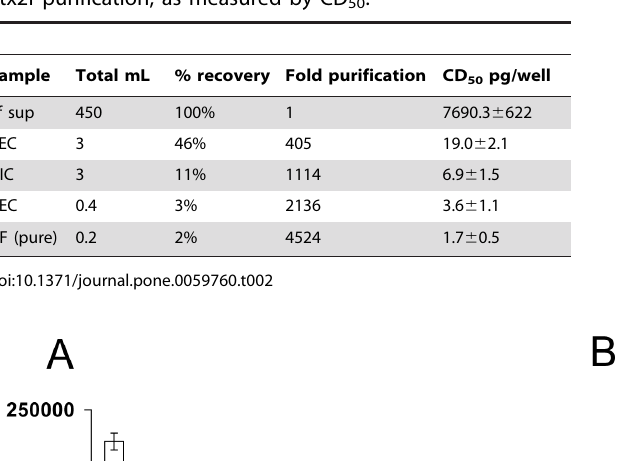
Table 3. Calculated CD 50 ’s for Stx2f and Stx2a by two different treatment